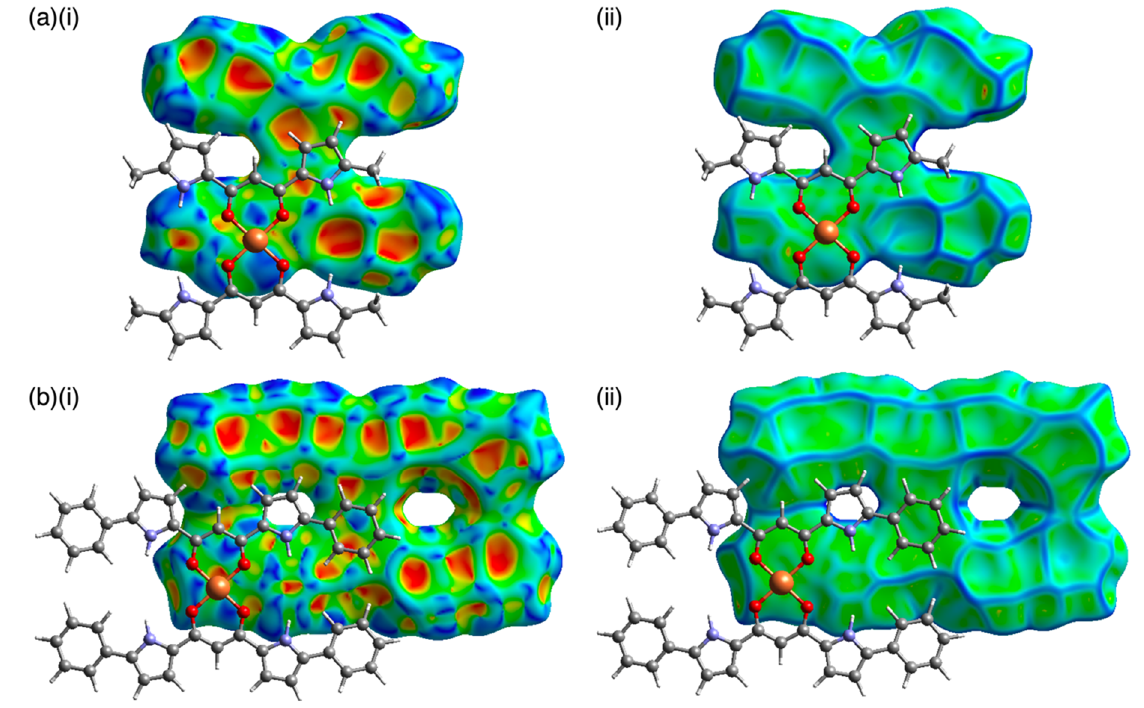
Figure 5. Hirshfeld surfaces of dipyrrolyldiketone Cu II complexes ( a ) 1a and ( b ) 2a as two stacking molecules ((i) mapped over shape-index and (ii) curvedness properties). Solvent molecules are omitted for clarity. Color code: Gray, white, blue, red, and orange refer to carbon, hydrogen, nitrogen, oxygen, and copper, respectively. Molecules 2021 , 26 , x FOR PEER REVIEW